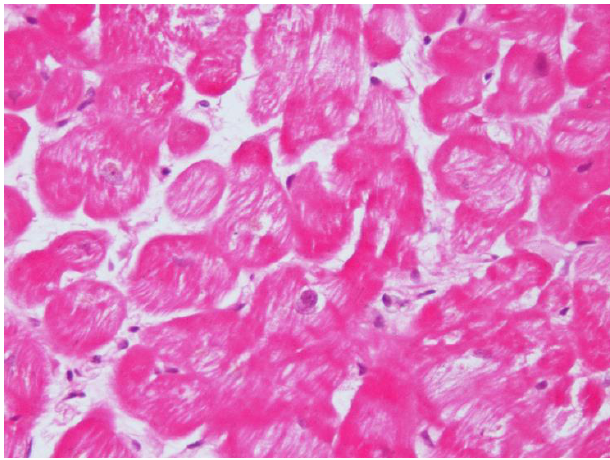
Figure 2. Hematoxylin and eosin staining (200×) shows a reduction in contractile elements because of gluconeogenesis due to cortisol overproduction in Cushing’s syndrome. gluconeogenesis due to cortisol overproduction in Cushing’s